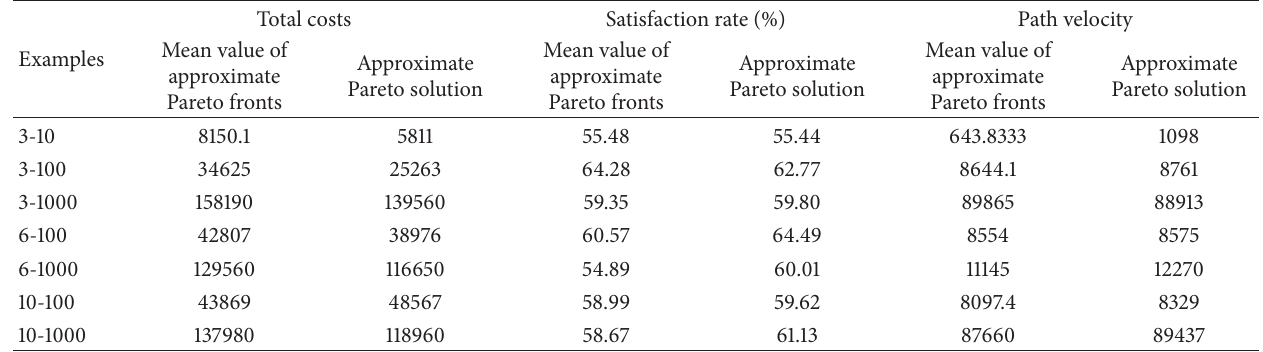
Table 3: Calculation